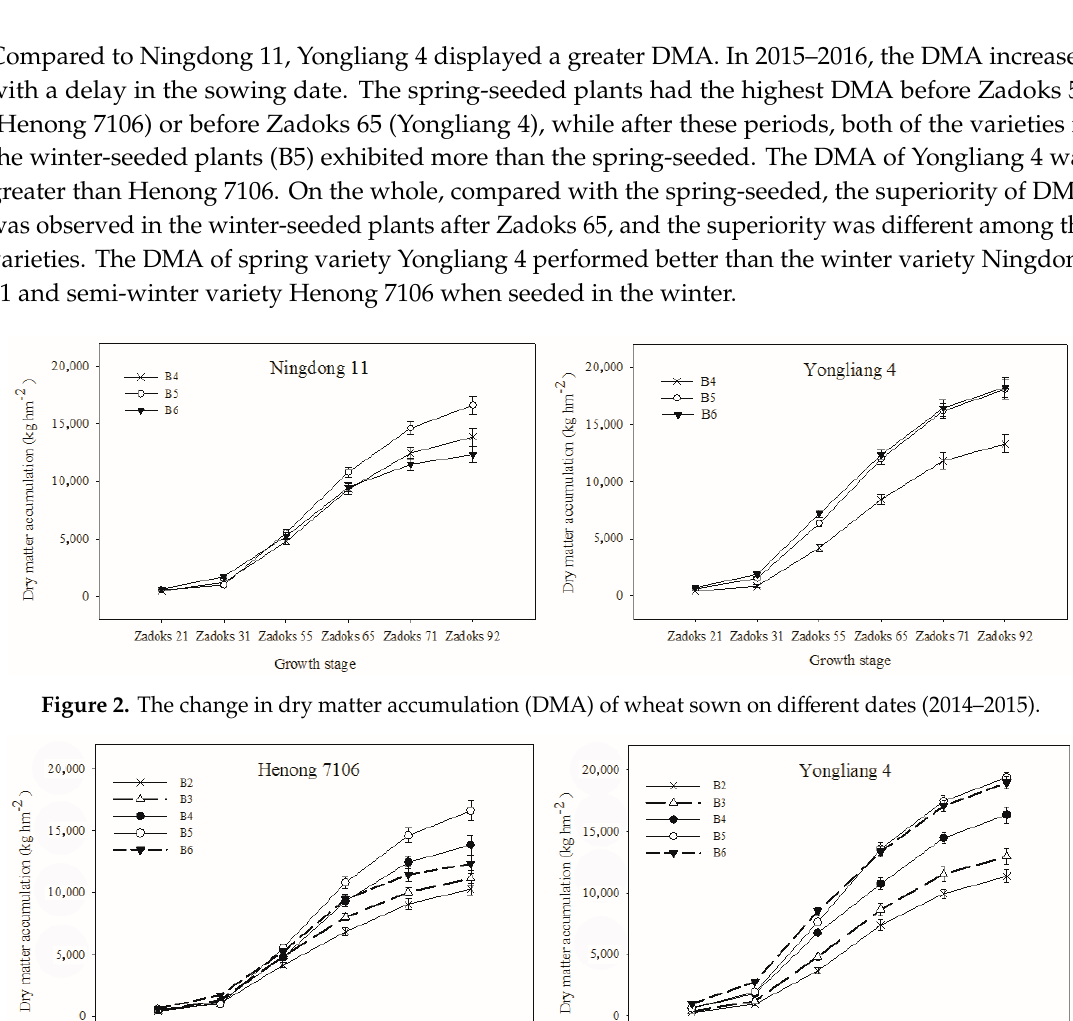
Figure 3. The di ff erences in dry matter accumulation (DMA) of wheat sown on di ff erent dates Figure 3. The differences in dry matter accumulation (DMA) of wheat sown on different dates (2015– 2016).